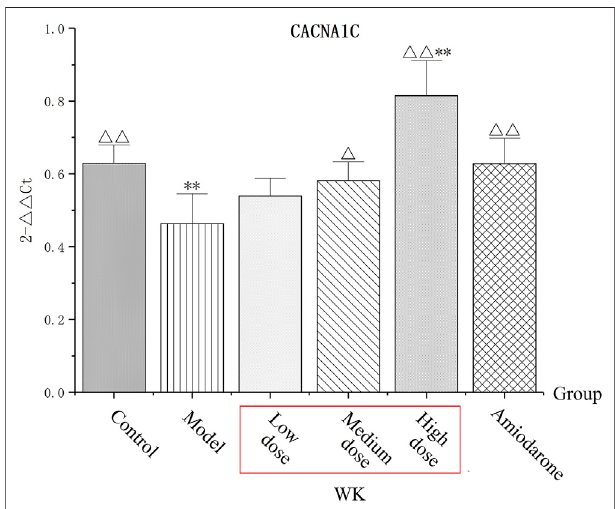
FIGURE 7 | The level of CACNA1C. ( x ± s , n (cid:1) 8) * p < 0.05, ** p < 0.01, versus the control group. △ p < 0.05, △△ p < 0.01, versus the model group.